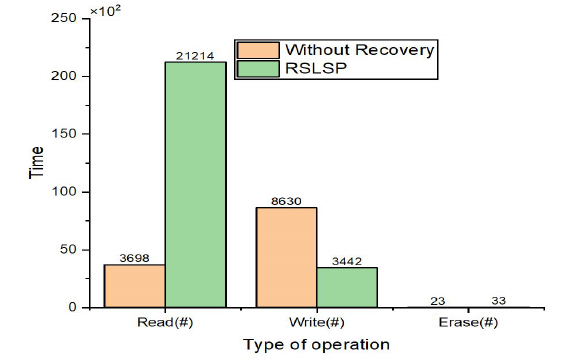
Figure 10. Results (time): for pattern B.